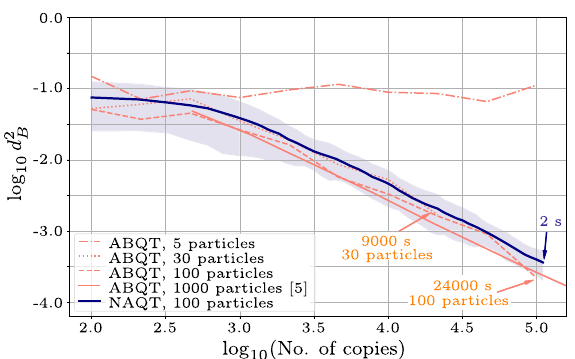
Fig. 2 Performance comparison for basis POVMs. Our neural network algorithm NAQT with 100 particles is compared against ABQT runs with 5, 30, and 100 particles; the data for ABQT with 1000 particles are extracted from ref. 12 . The plot gives the reconstruction accuracy against a number of copies measured. The light-blue shading gives the 1 σ error bars for NAQT. Our NAQT algorithm performs comparably, in terms of reconstruction accuracy, to ABQT; the runtimes are, however, signi fi cantly — by a factor of a few thousand — more favorable for NAQT than